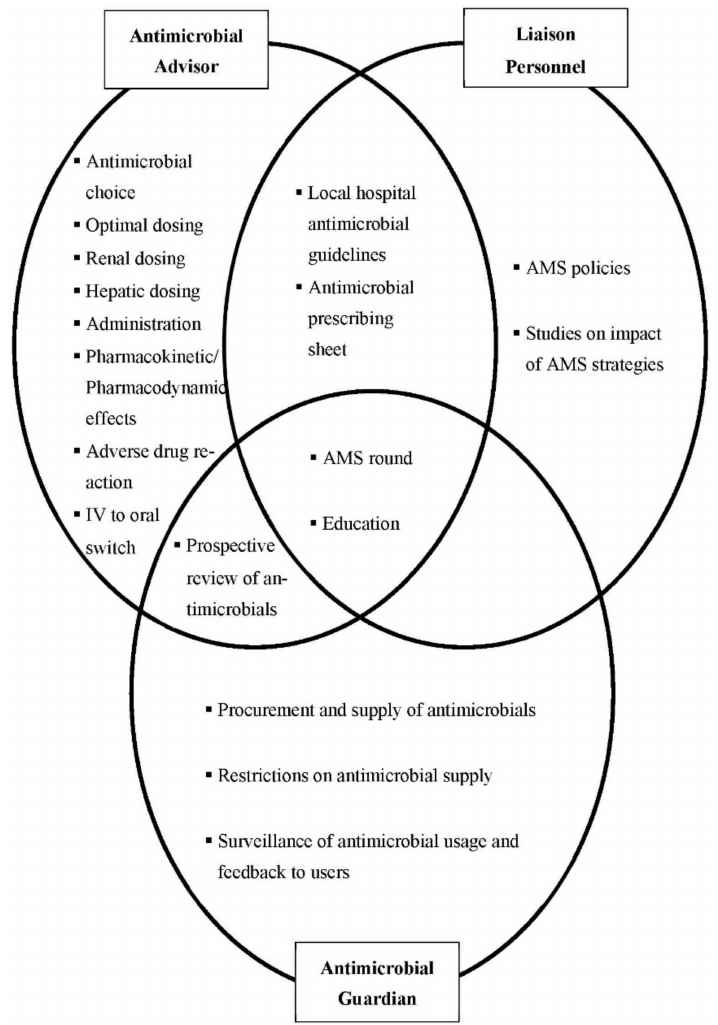
Figure 1. The interplay of pharmacists’ roles in the implementation of antimicrobial stewardship (AMS)